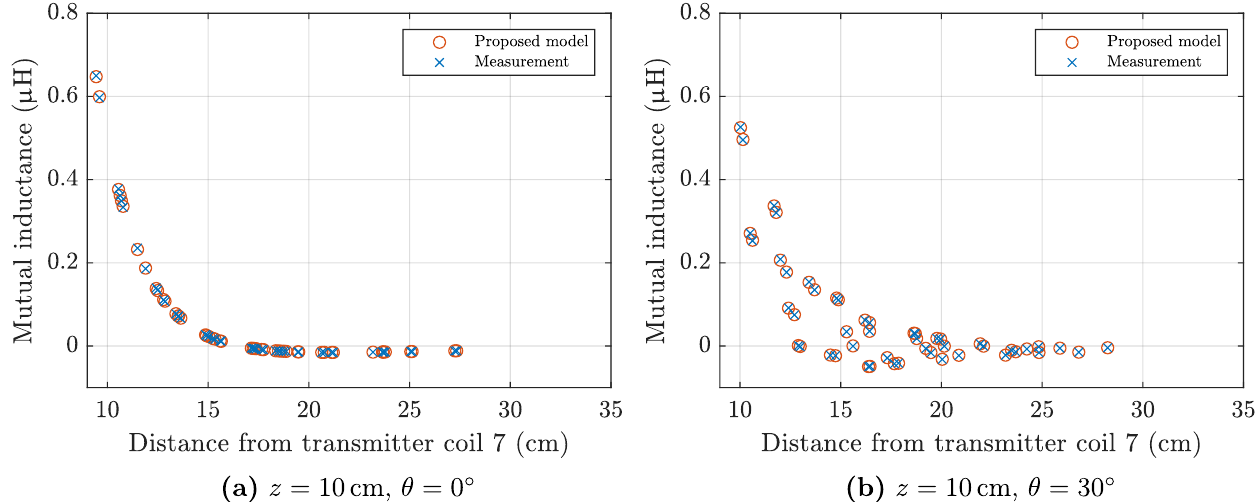
Figure 11. Mutual inductance between coil a of Figure 8a, and transmitter coil 7 of the field generator, as defined in Figure 10a. Experimental values are compared to those predicted by the analytical model of Section 2. ( a ) Test points at 10cm from the planar field generator, pitch angle θ = 0 ◦ . ( b ) Test points at 10cm from the planar field generator, pitch angle θ = 30 ◦